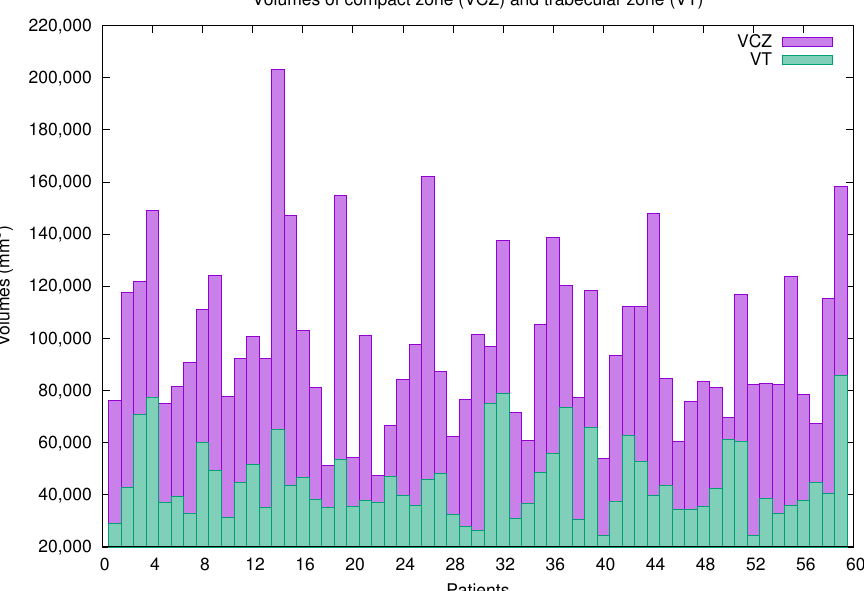
Figure 2. Volume of the compact zone (VCZ) and volume of the trabecular area (VT) computed by QLVTHCI for patients